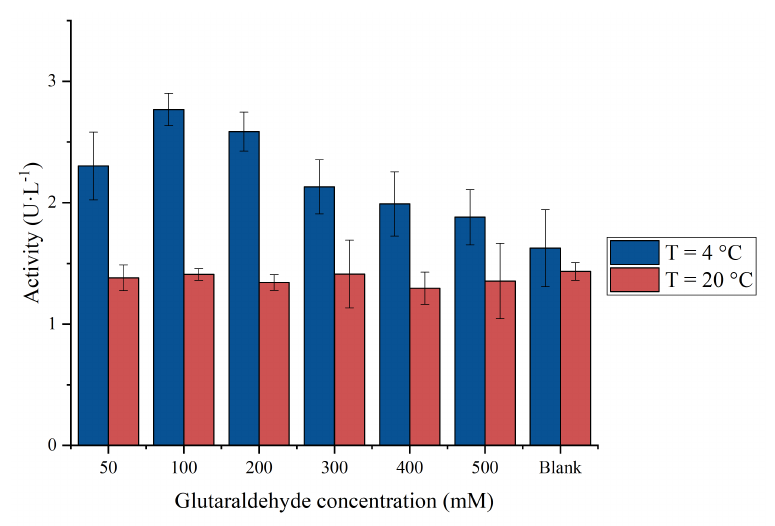
Figure 4. Effect of GA concentration and temperature on the enzymatic activity of the membrane. Measured with the following settings: adsorption: 3 mg·mL − 1 laccase in pH4 for 9 h at 29 ◦ C, cross-linking: 50–500 mM at 4 ◦ C (blue) and 20 ◦ C (red), reaction time: 2